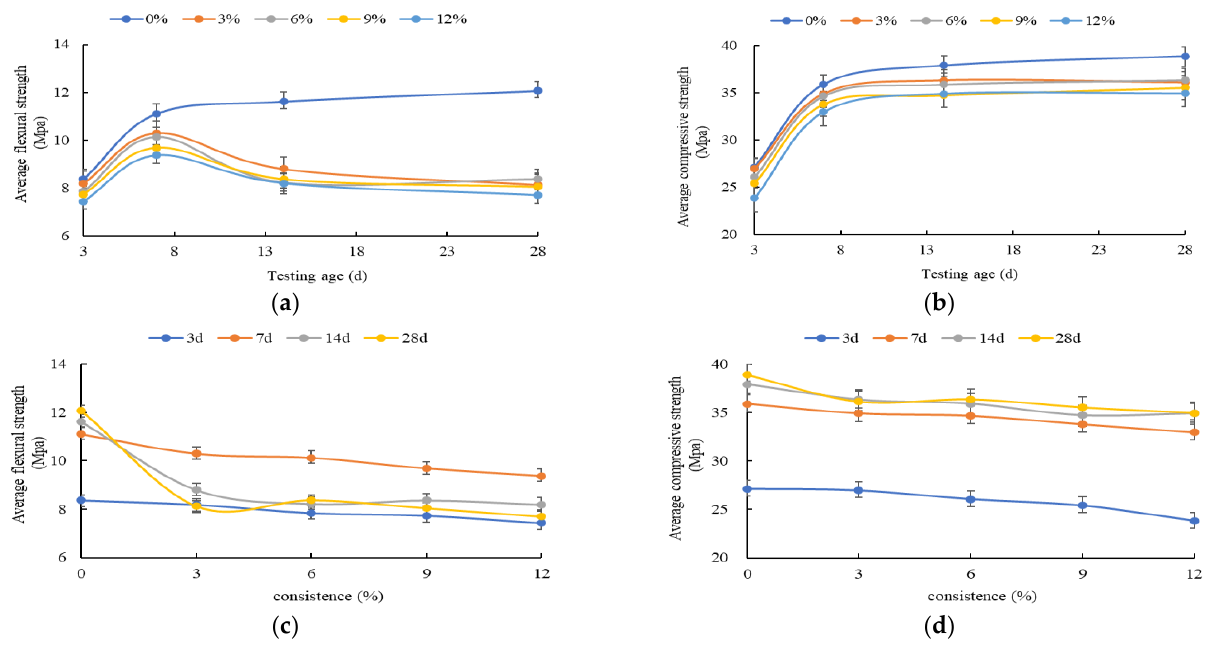
Figure 3. The flexural and compressive strength curves: ( a ) Flexural strength; ( b ) Compressive strength; ( c ) Flexural strength; ( d ) Compressive